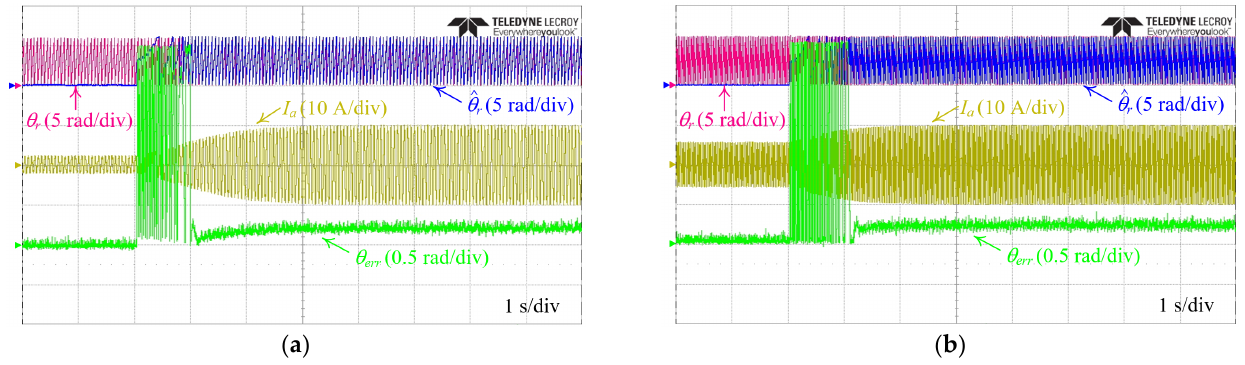
Figure 14. Experimental results of the conventional method and its position estimation error at 500 rpm and 1000 rpm. ( a ) θ r , ˆ θ r , I a , and θ err at 500 rpm; ( b ) θ r , ˆ θ r , I a , and θ err at 1000